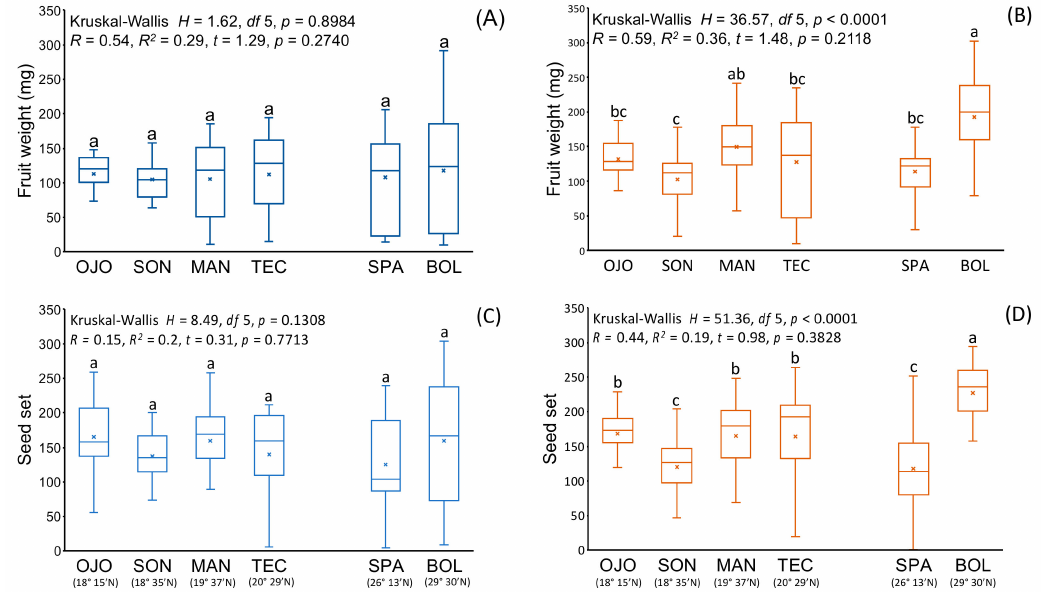
Figure 2. Fruit weight ( A , B ) and seed set ( C , D ) obtained by self- (blue boxes) and cross-pollination (orange boxes) in native populations of Oenothera drummondii . Comparison among populations (Kruskal–Wallis nonparametric ANOVA) and the relationship between the reproductive characteristic and latitude (linear regression analysis) are shown in each graph. Population acronyms are explained in Table A1. Latitudinal ubication is indicated below each acronymous. Different letters above the boxes indicate significant differences among populations (Steel–Dwass all pairs multiple comparisons p < 0.001). Boxes show the average (x), median (-) and quartiles.